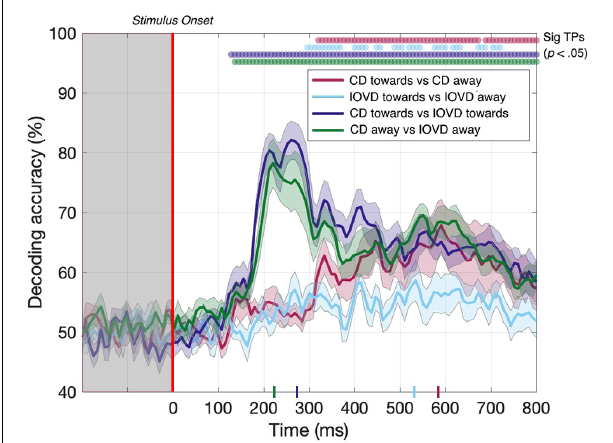
FIGURE 5 | Pairwise decoding accuracy across 125 time points for four stimulus conditions. Red, light blue, dark blue, and green dots indicate time points when the Bonferroni-corrected t -tests were significant for each condition ( p < 0.05) and the colored ticks on the x -axis represent the time point of peak decoding performance for each stimulus condition. Shaded error bars represent ± 1SE of the bootstrapped mean (1000